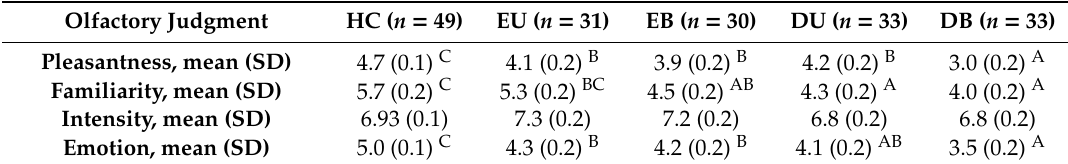
Table 2. Mean scores (standard deviation) for the olfactory judgments of all odors evaluated by HC, EU, EB, DU, and DB patients. For each olfactory judgment, if the means share the same letter, they are not significantly di ff erent at the 5% level of significance (Tukey test).